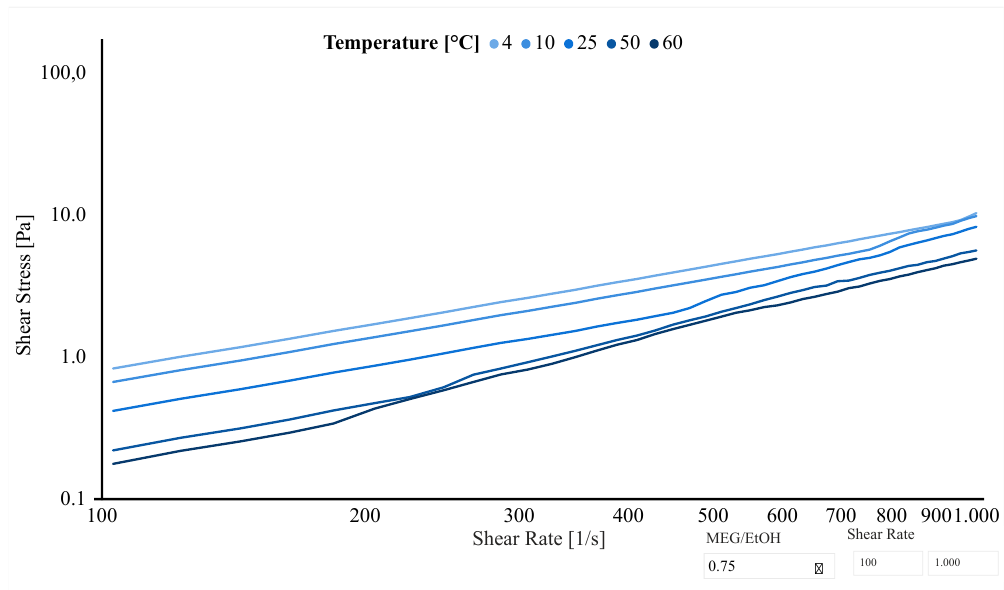
Figure 7. Shear stress Vs. Shear rate for different temperatures for a 75%